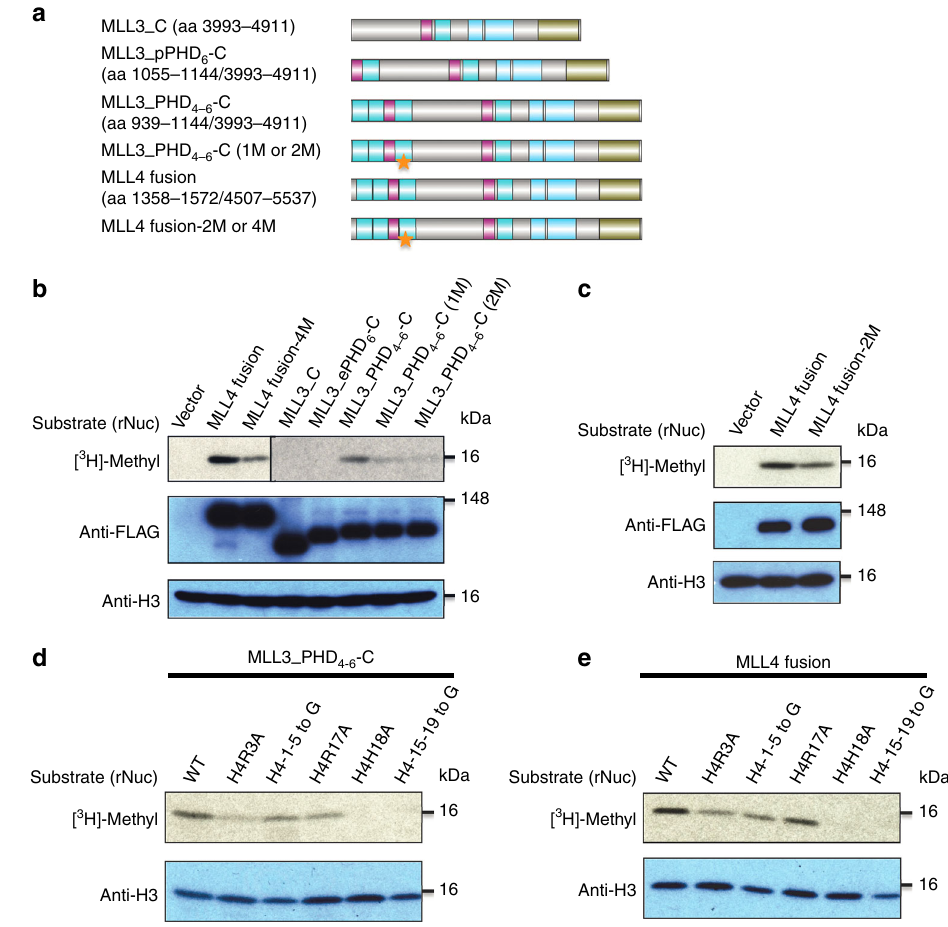
Fig. 3 Interaction between ePHD 6 of MLL3/4 and histone H4 is required for their nucleosomal methylation activity. a Schematic representation of constructs used in the histone methyltransferase (HMT) assay. Stars indicate the mutations in PHD 6 of MLL3/MLL4. 1 M is W1109A single point mutation of MLL3, 2 M: W1109A/E1120A and W1529A/E1540A are double point mutations of MLL3 and corresponding residues in MLL4, respectively,